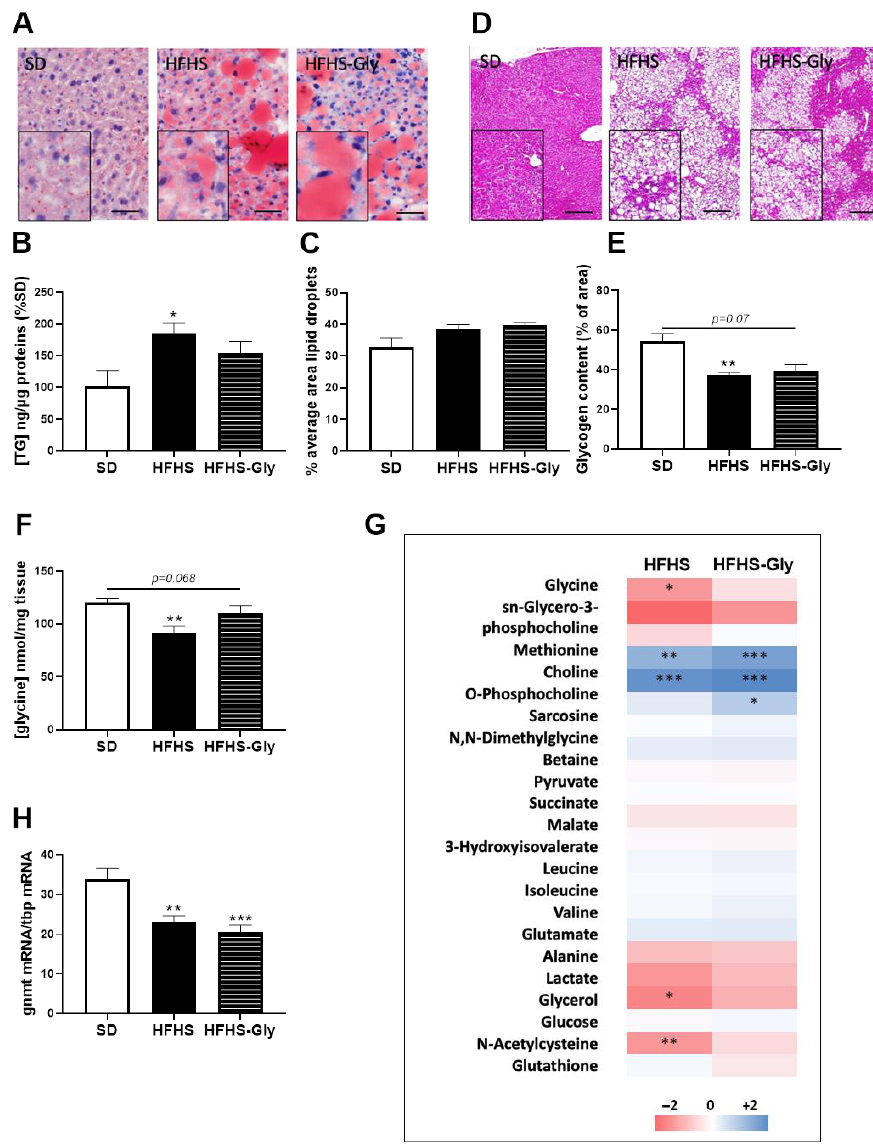
Figure 2. The impact of obesogenic diet and glycine on hepatic metabolism. C57Bl6JOlaHsd mice were fed a standard diet (SD) or a high-fat high-sucrose diet (HFHS) for 16 weeks. Glycine